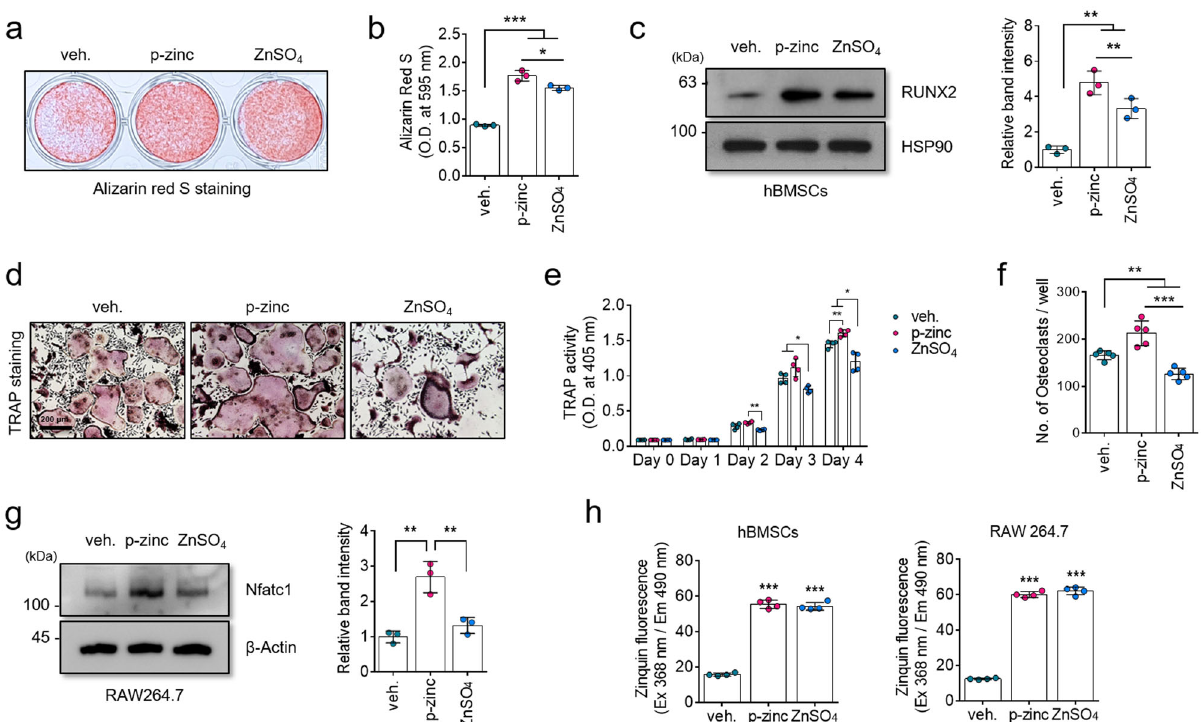
Fig. 3 Comparative study of polaprezinc and zinc-sulfate differentiation into osteoblast and osteoclast lineages. a Alizarin red S staining was performed to detect mineral deposition on day 14 in differentiated hBMSCs treated with vehicle, polaprezinc (50 μ M), or zinc sulfate (50 μ M). b For quantitative analysis of alizarin red S staining, absorbance was measured at 595 nm following destaining with 10% cetylpyridinium for 30 min. c The protein level for RUNX2 was analyzed in hBMSCs using western blotting for cells treated with vehicle, polaprezinc (50 μ M), or zinc sulfate (50 μ M). The band intensity was quanti fi ed using ImageJ software ( n = 3, in triplicate) and each RUNX2 protein level was normalized to the HSP90 protein level. * P < 0.05; ** P < 0.01 compared with vehicle-treated hBMSCs. d Representative images of osteoclast differentiation. RAW264.7 treated with vehicle, polaprezinc (50 μ M), or zinc sulfate (50 μ M) were seeded into 12-well culture plates and treated for 5 days with osteoclastogenesis-related reagents. TRAP staining was performed to visualize TRAP-positive RAW264.7. Scale bar = 200 μ m. e TRAP activity was measured at 405 nm, and the data are expressed as the mean ± S.D. ( n = 3) from each independent experiment. f The number of TRAP-positive multinucleated osteoclasts (5 ≥ nuclei) was counted. g The protein level for NFATc1 was analyzed in RAW264.7 using western blotting for cells treated with vehicle, polaprezinc (50 μ M) or zinc sulfate (50 μ M). The band intensity was quanti fi ed using ImageJ software ( n = 3, in triplicate) and each Nfatc1 protein level was normalized to the β -Actin protein level. ** P < 0.01 compared with vehicle-treated RAW264.7. h Cells treated with vehicle, polaprezinc (50 μ M), or zinc sulfate (50 μ M) were incubated with 25 μ M of Zinquin for 30 min at 37 °C. The fl uorescence intensity was measured at excitation 368 nm and emission 490 nm using a fl